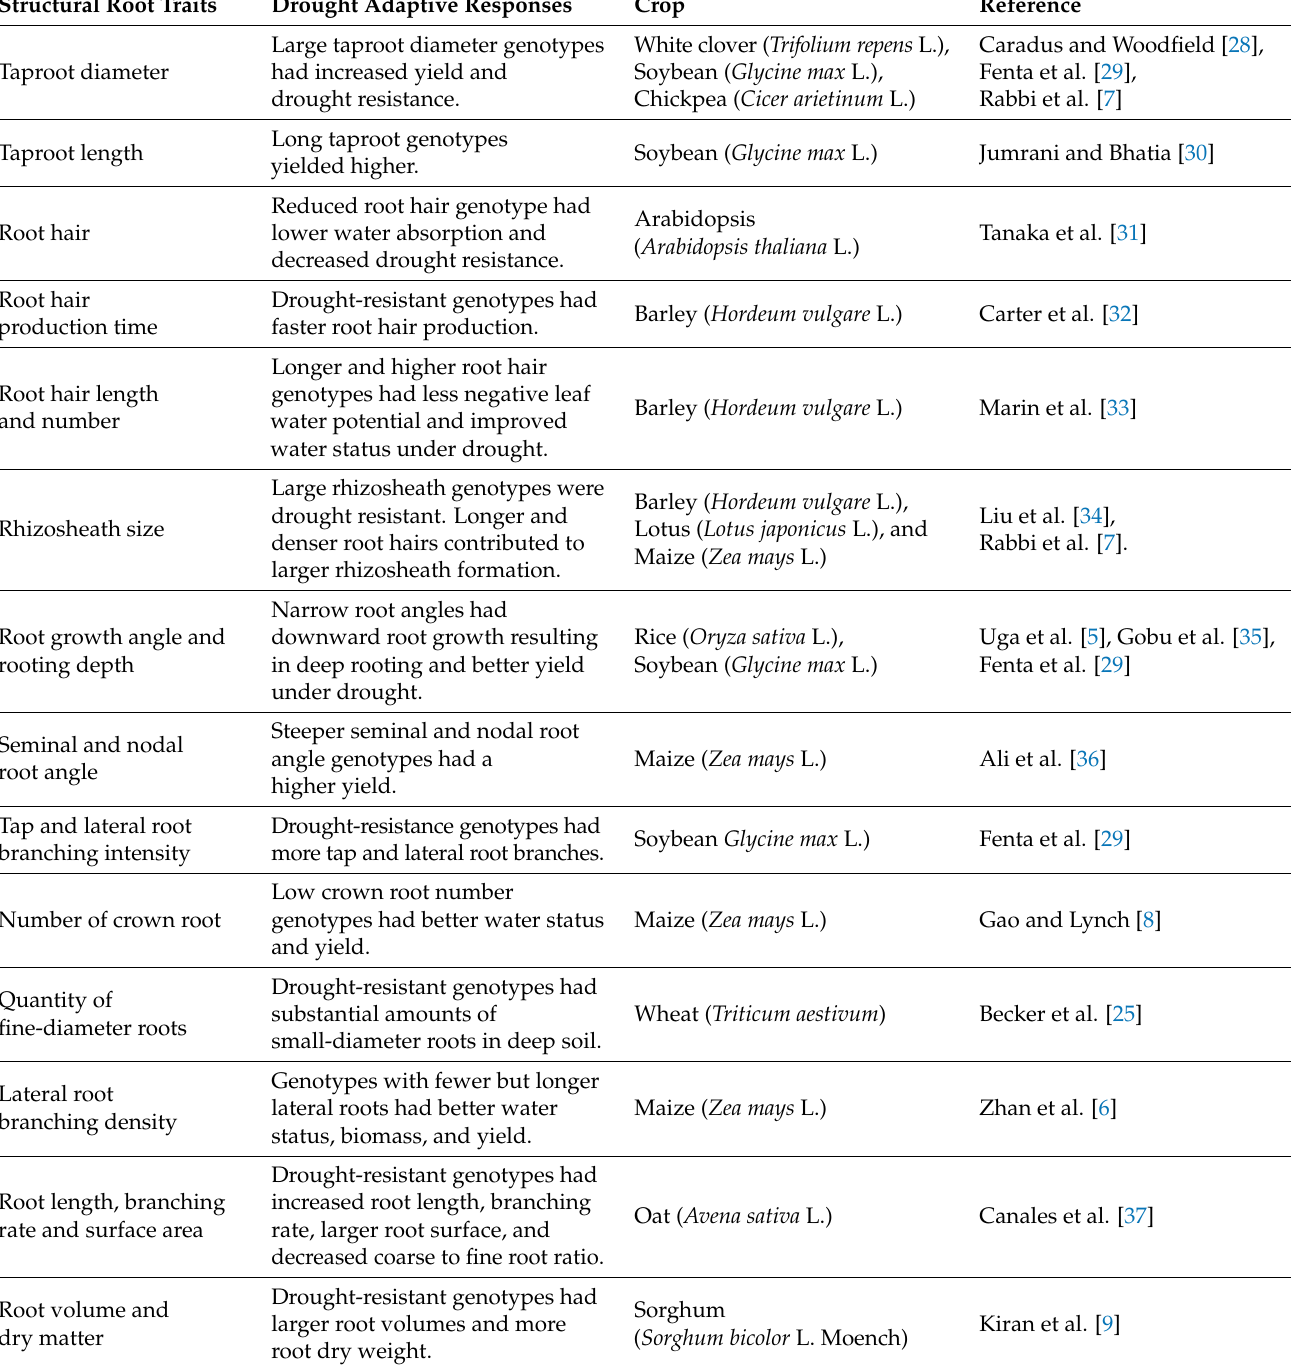
Table 1. Root structural traits and their adaptive response to